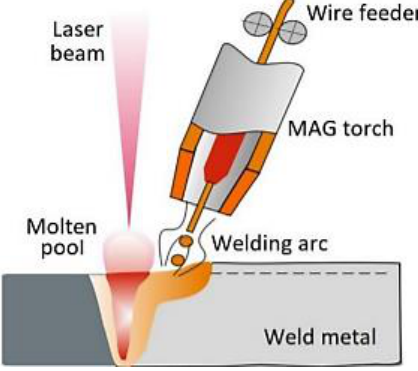
Figure 1. Schematic diagram of HLAW [19].